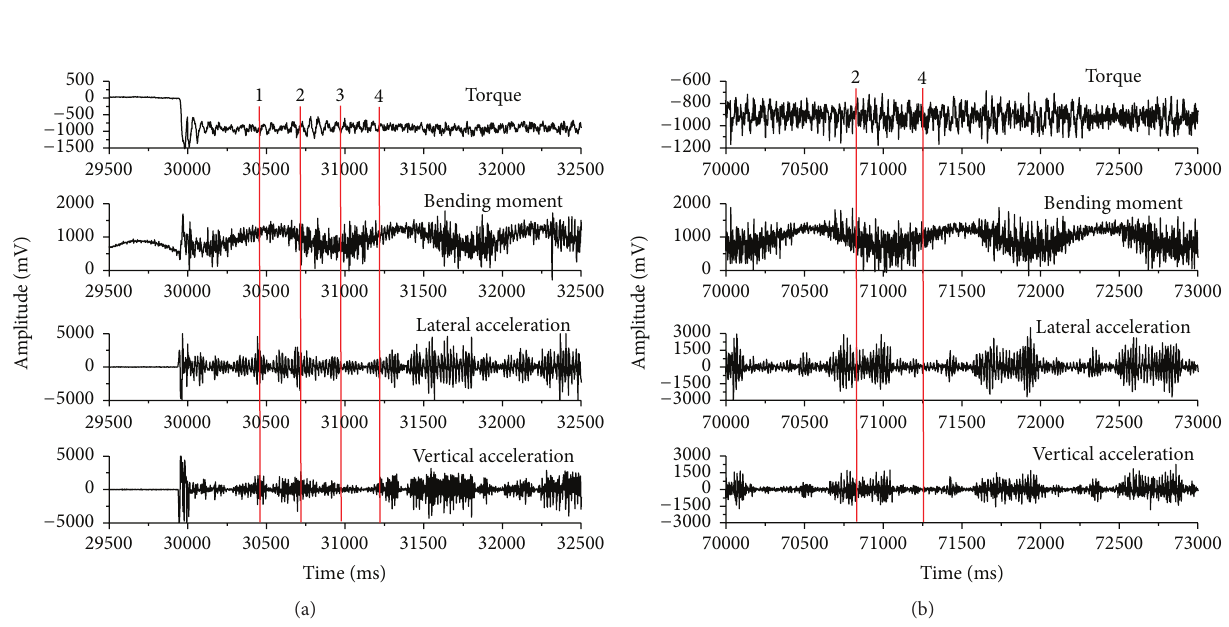
Figure 12: Roller system vibration measurement